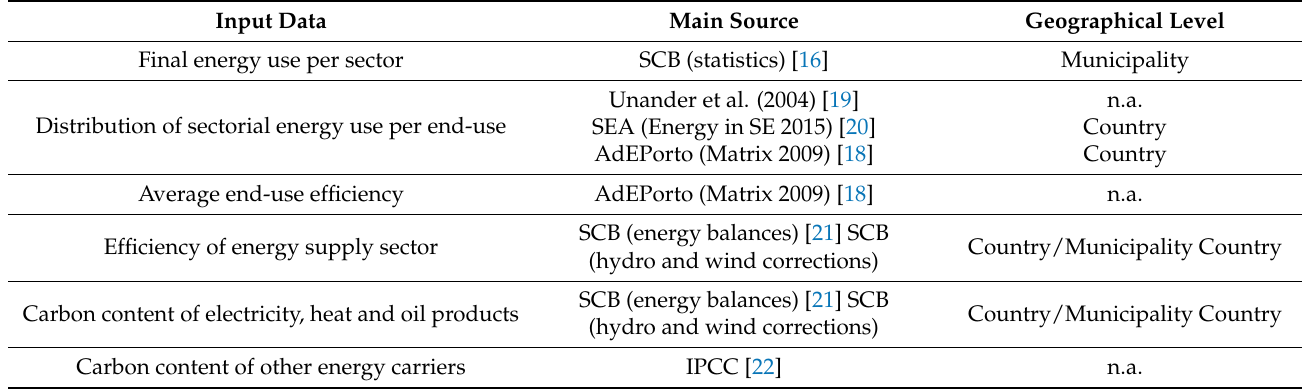
Table 3. Input data to build the energy and emissions matrices for the municipality of Malmö for 1990 and 2015, with the identification of main sources and data geographical level.